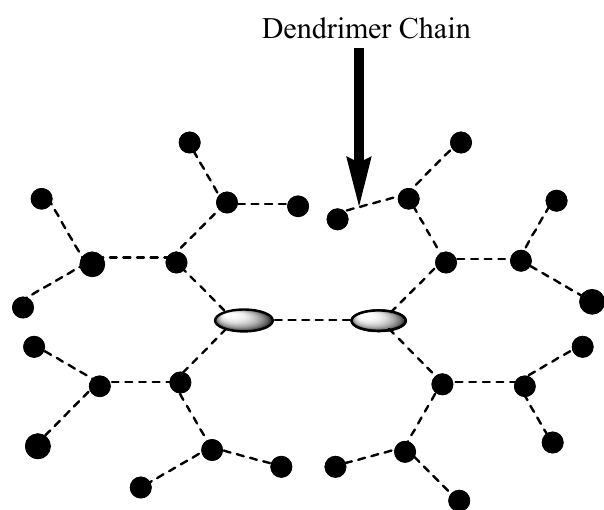
Figure 6. Schematic diagram of a dendrimer.